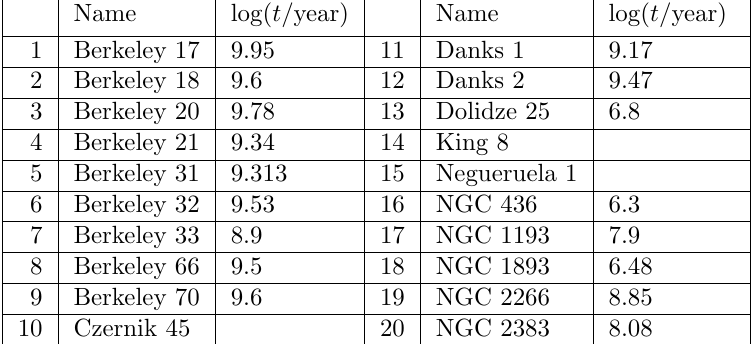
Table 1. List of open clusters with unusual trajectories characterized by large height from the Galactic plane.